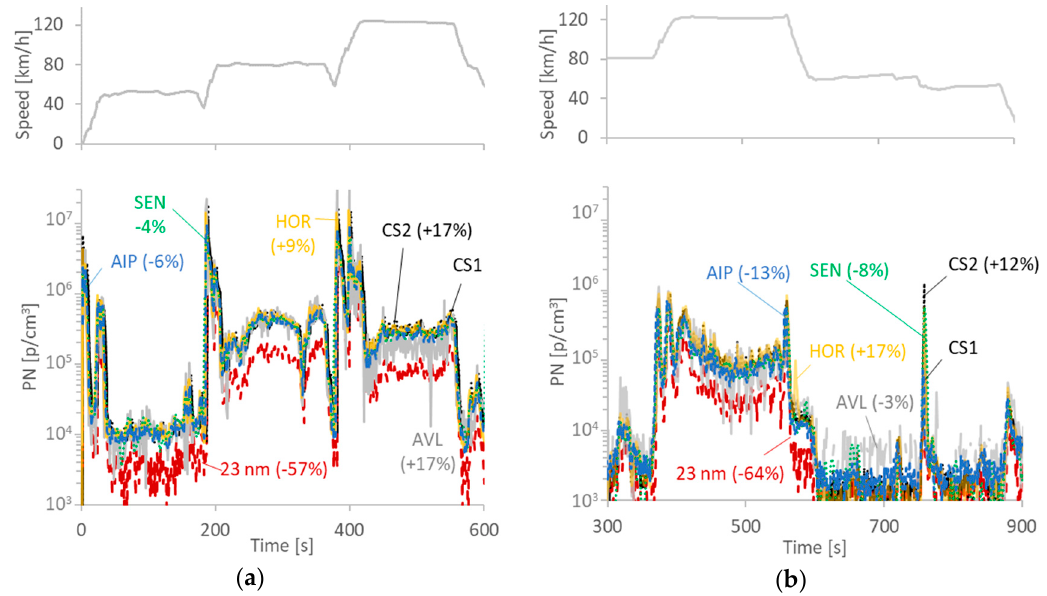
Figure 7. Particle number (PN) concentration examples for: ( a ) PFI vehicle; ( b ) LPG vehicle. Upper panels plot the speed profiles.